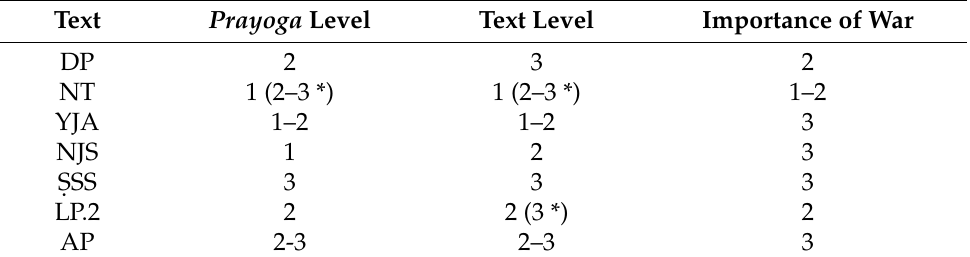
Table 3. The degree of transgression in war prayogas in the mixed texts compared to the overall character of each text and the importance of war-related